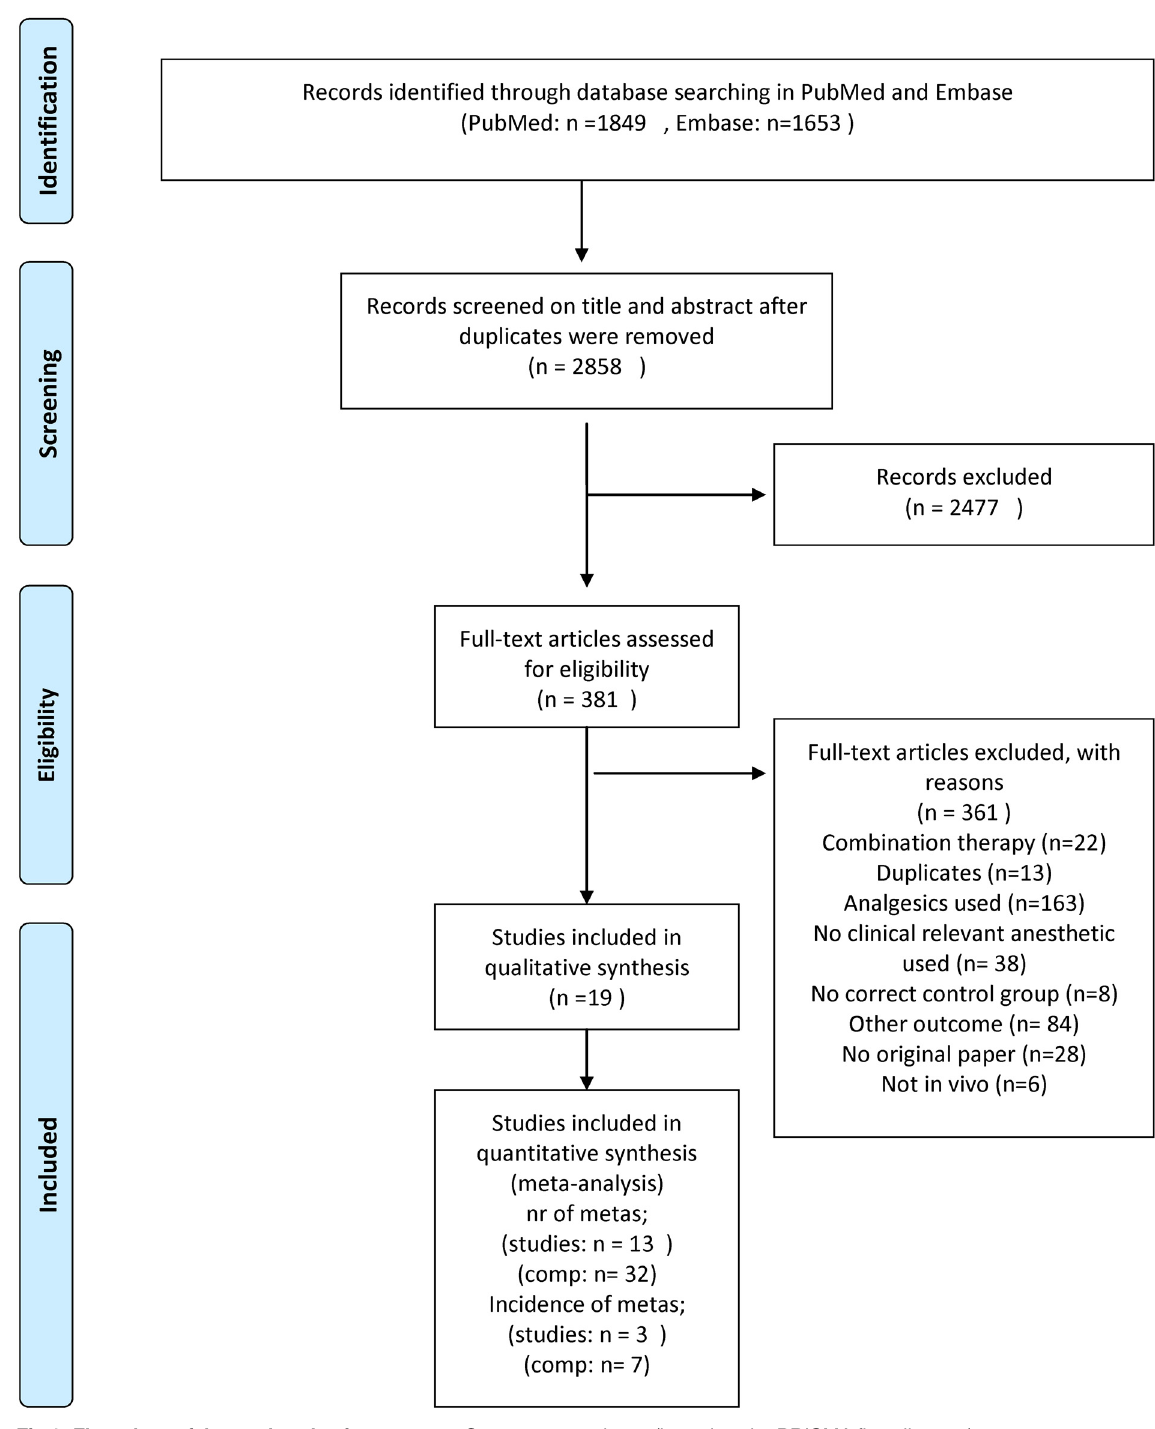
Fig 1. Flow chart of the study selection process. Comp = comparisons (based on the PRISMA flow diagram).